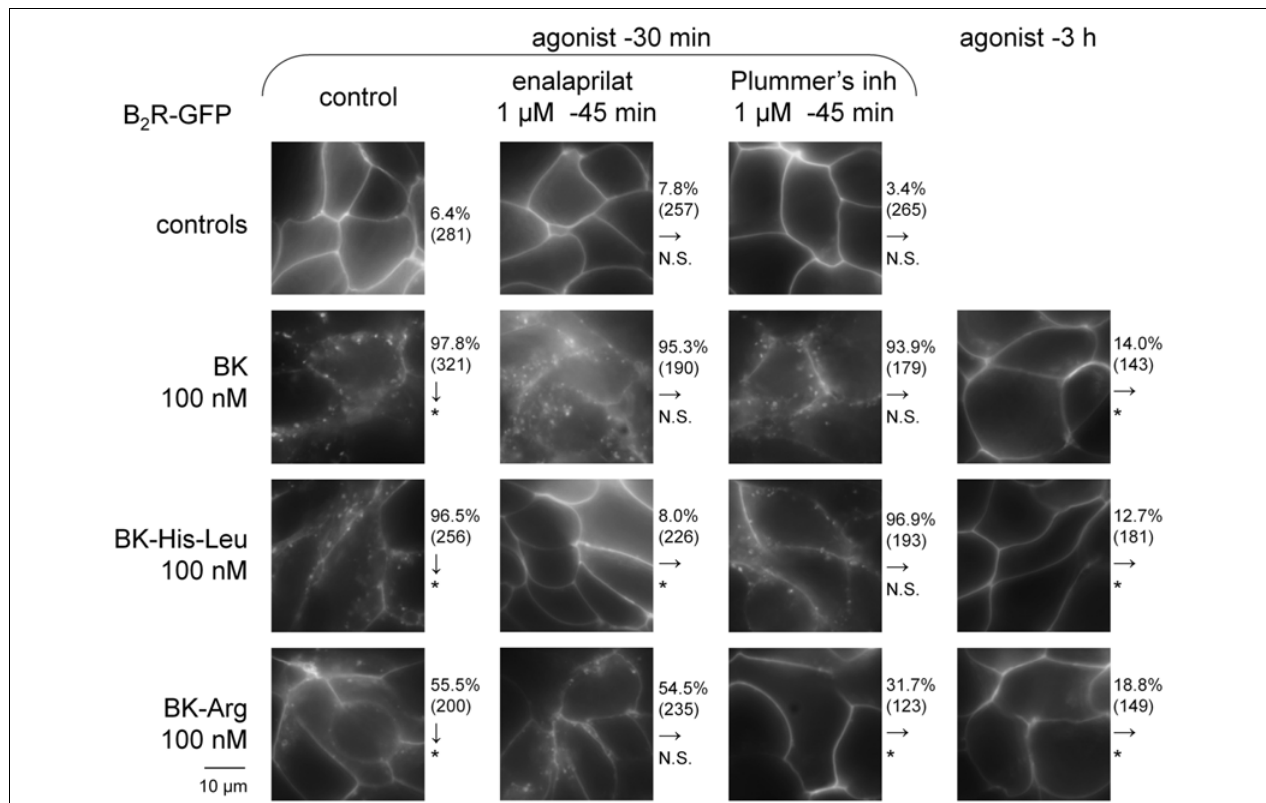
each experimental condition on the proportion of cells showing evidence of B 2 R-GFP internalization was evaluated using χ 2 statistics relative to the control condition indicated by arrows (either control cells for vertical arrows, or the left-most conditions for horizontal arrows; * P < 10 − 3 , N. S.